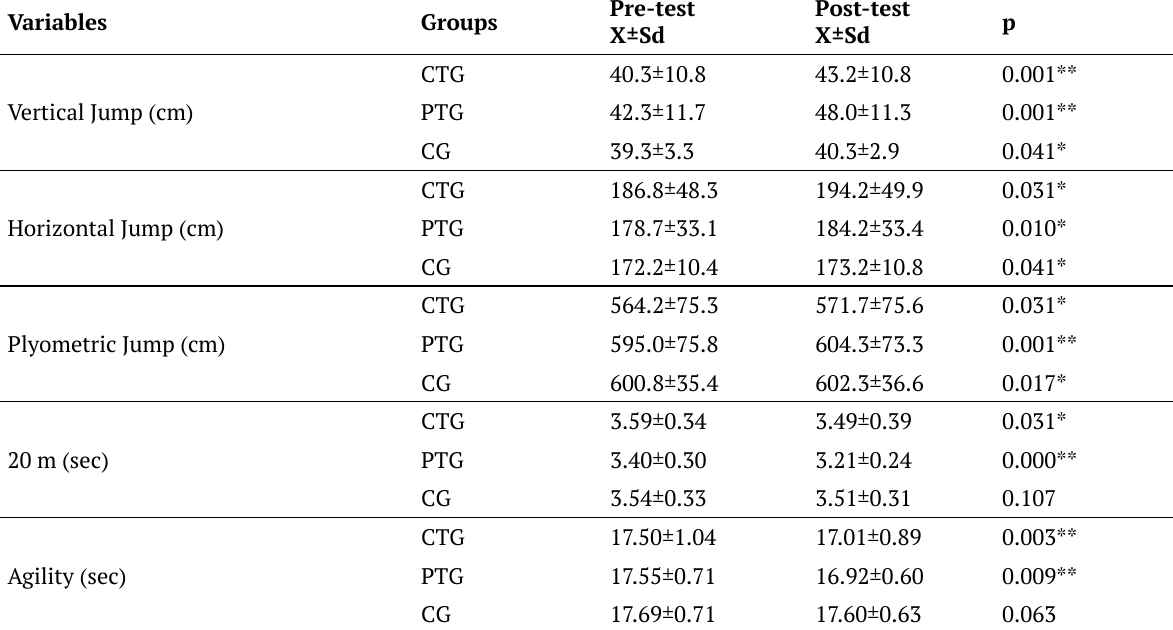
Table 5. Comparison of in-group athletic performance data of young male soccer players before and after core and plyometric